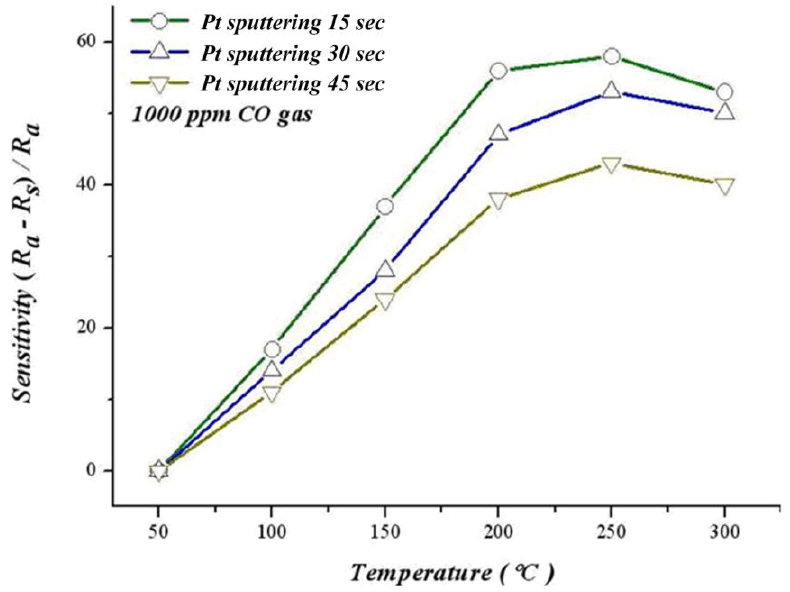
Figure 15. Relation between temperature and sensitivity during various platinum deposition